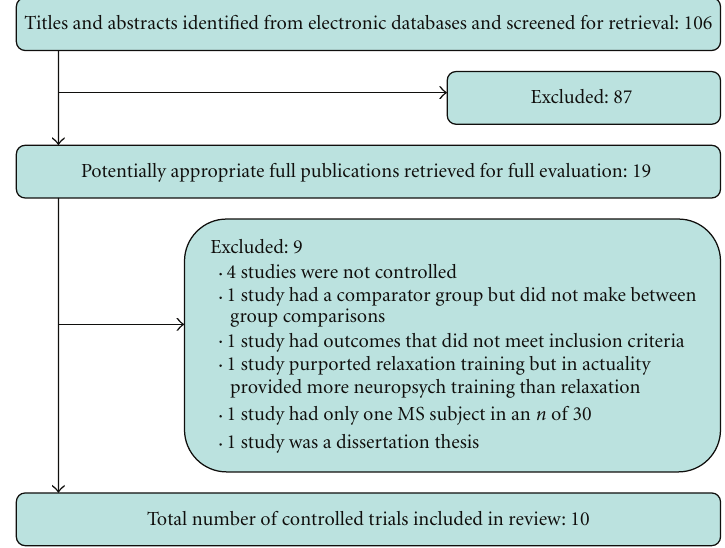
Figure 1: Flow diagram of literature search and study selection